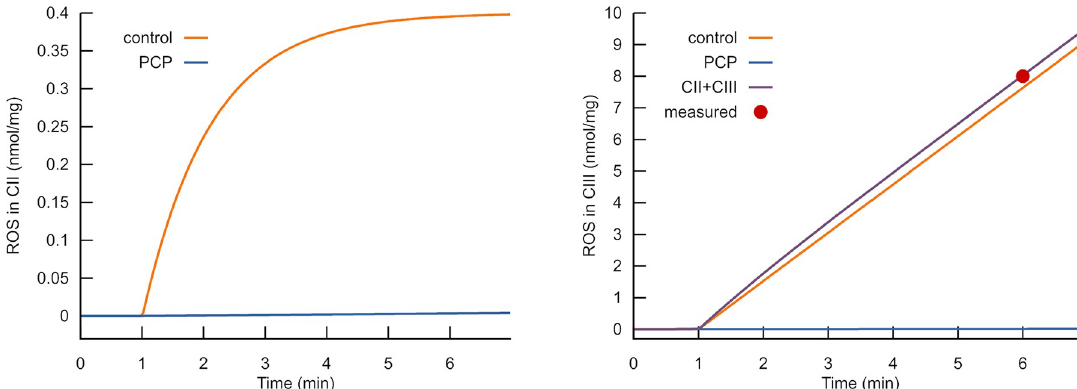
Fig 4. Uncoupling prevents the glutamate stimulated ROS production. Calculated ROS accumulation produced in complexes II (A) and III (B) after complex II activation by glutamate in the presence (blue curves) and absence (orange curves) of an uncoupling agent. Uncoupling is simulated as an increase of proton leak rate constant (from 2 to 40 s -1 × mV -1 ). The calculations stimulated the application of uncoupler PCP, as reported in Fig 6 of [29].